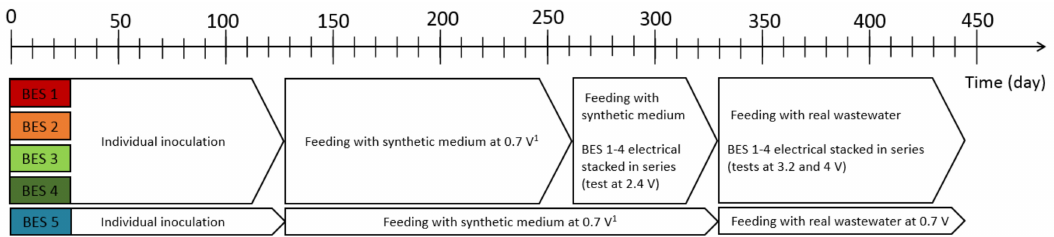
Figure 4. Timeline of performed experiments on the five replicate EMG-BES reactors. 1 In this period, complementary tests on applied voltage/cathode potential were performed (data not